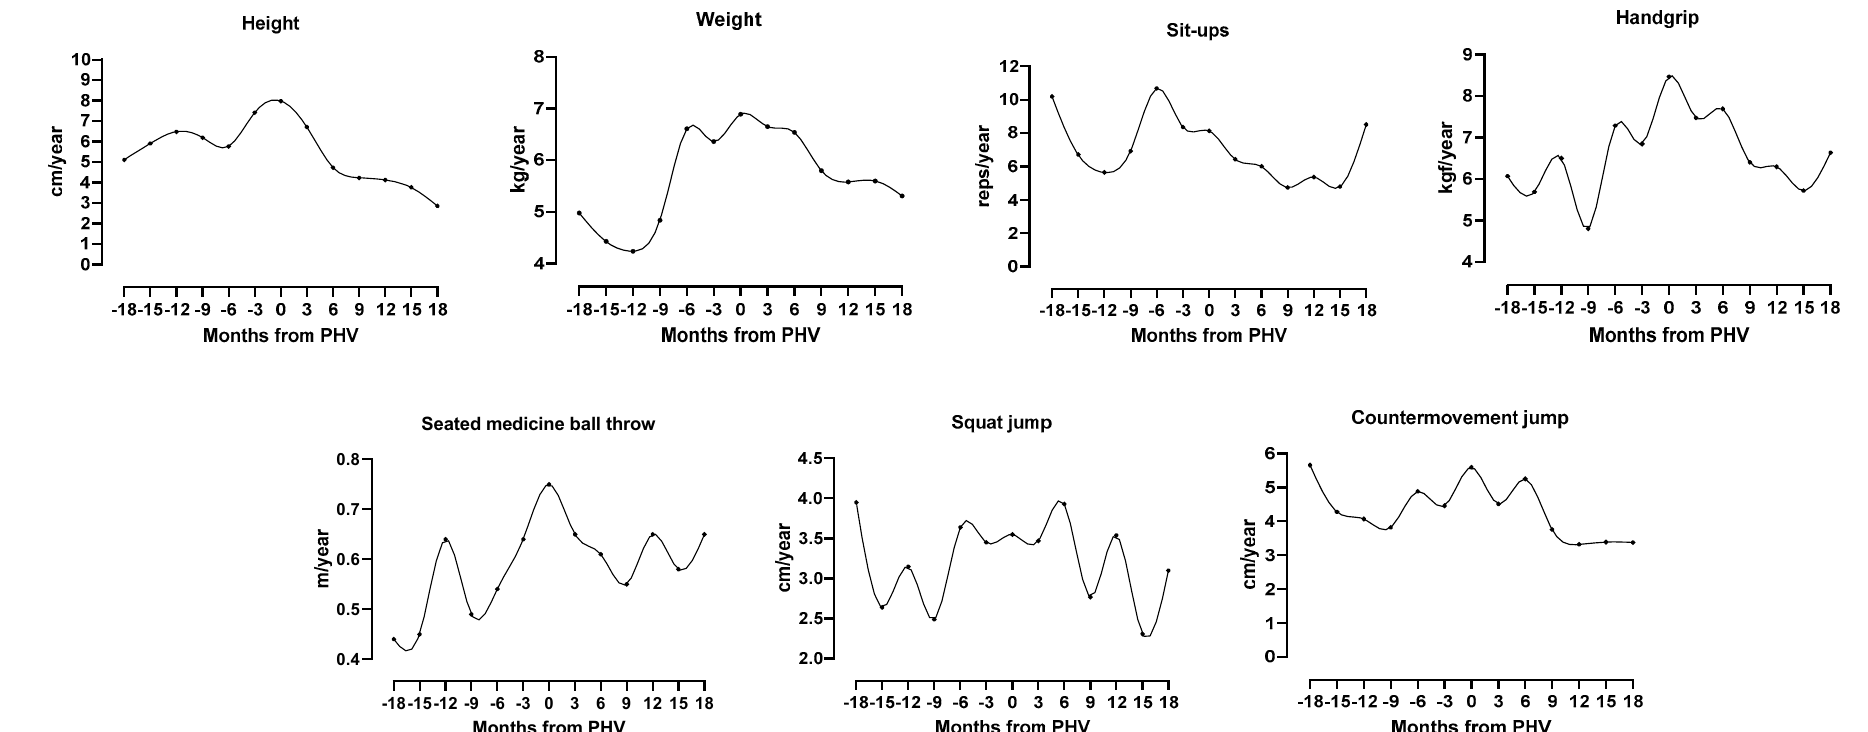
Figure 1. Mean velocity curves for height, weight and muscular strength components aligned by biological age (months from peak height velocity (PHV)); 0 = PHV.